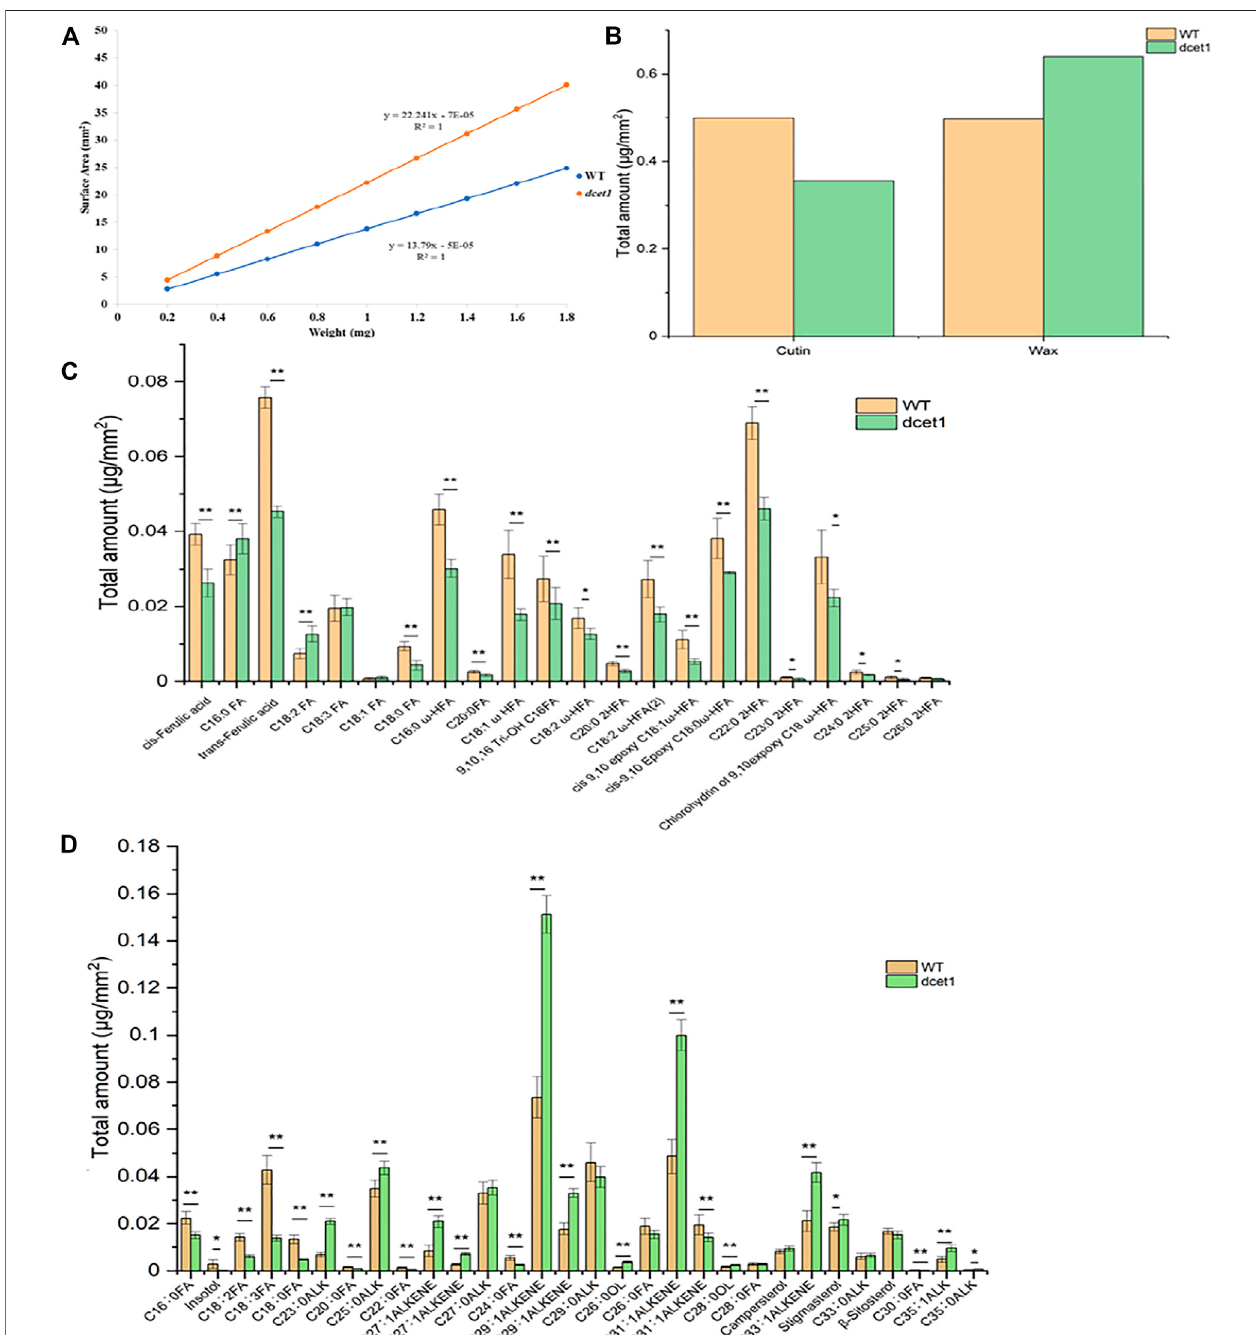
FIGURE 8 | Analysis of anther wax and cutin in the wild-type (WT) and mutant ( dcet1 ). Weight/surface area ratio of the WT and dcet1 anthers (A) . Total wax and cutinamountsperunitsurfaceareainWTand dcet1 anthers (B) .CutinmonomeramountperunitsurfaceareainWTand dcet1 anthers (C) .Waxconstituentamountper unit surface area in WT and dcet1 anthers (D) . R 2 represents regression values. Error bars indicate ± SD ( n (cid:1) 5). * p-value < 0.05; ** p -value < 0.01 by Student ’ s t -test.